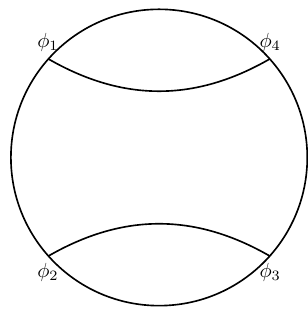
Figure 1 . Generalised free (cid:12)elds in the t -channel (23)